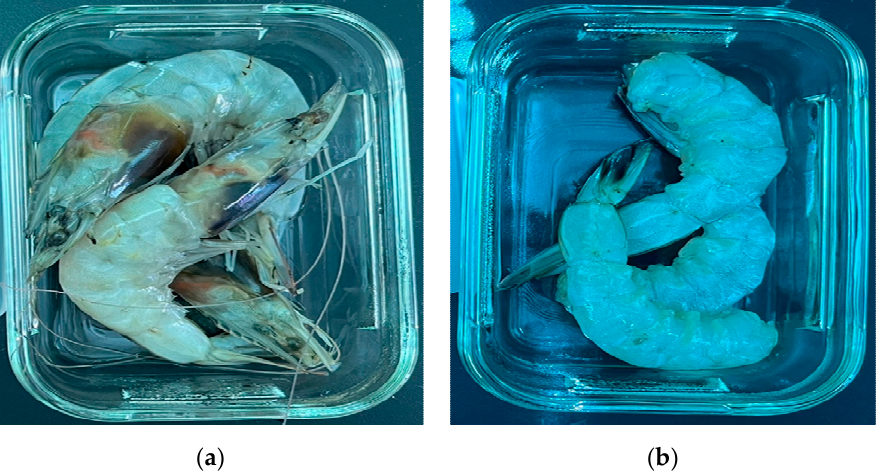
Figure 1. Shrimp picture used in the experiment: ( a ) With shrimp intestines and heads; ( b ) Without shrimp intestines and heads.